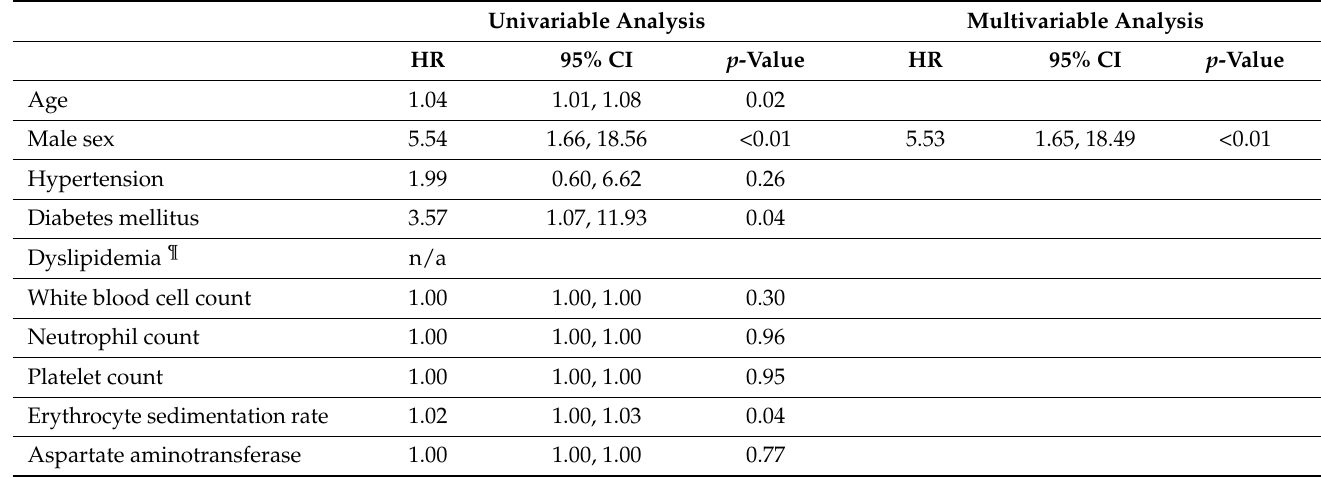
Table 6. Cox proportional hazard analysis of factors associated with all-cause